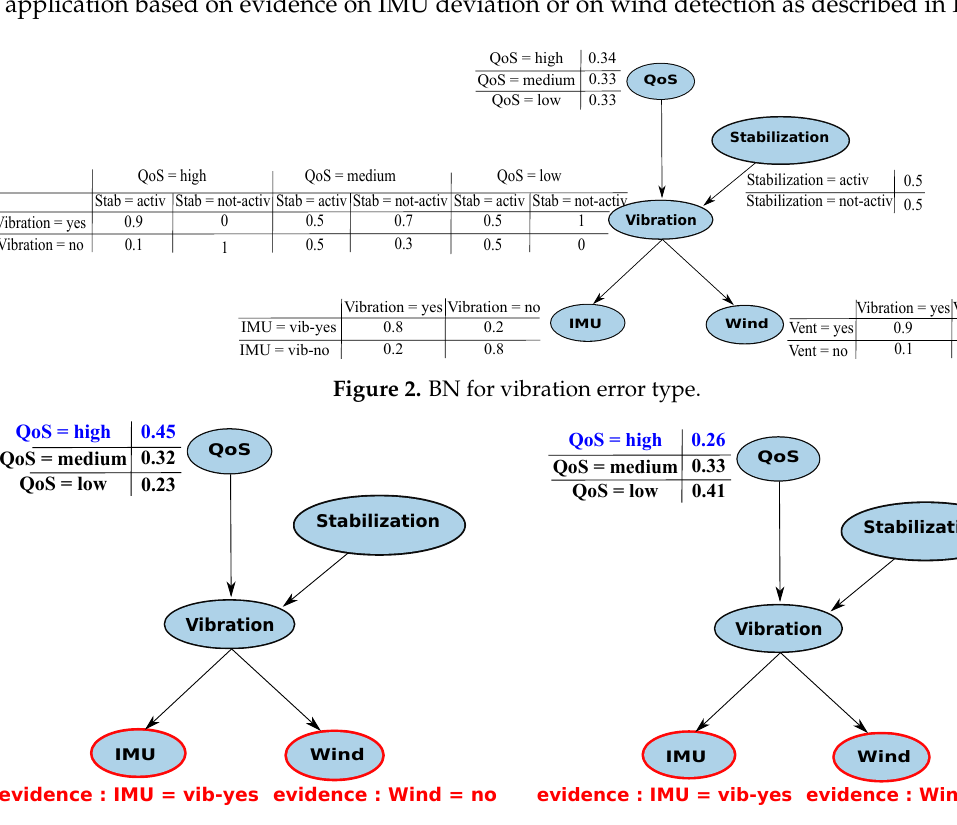
Figure 3. Application Quality of Service (QoS) probability under the observed